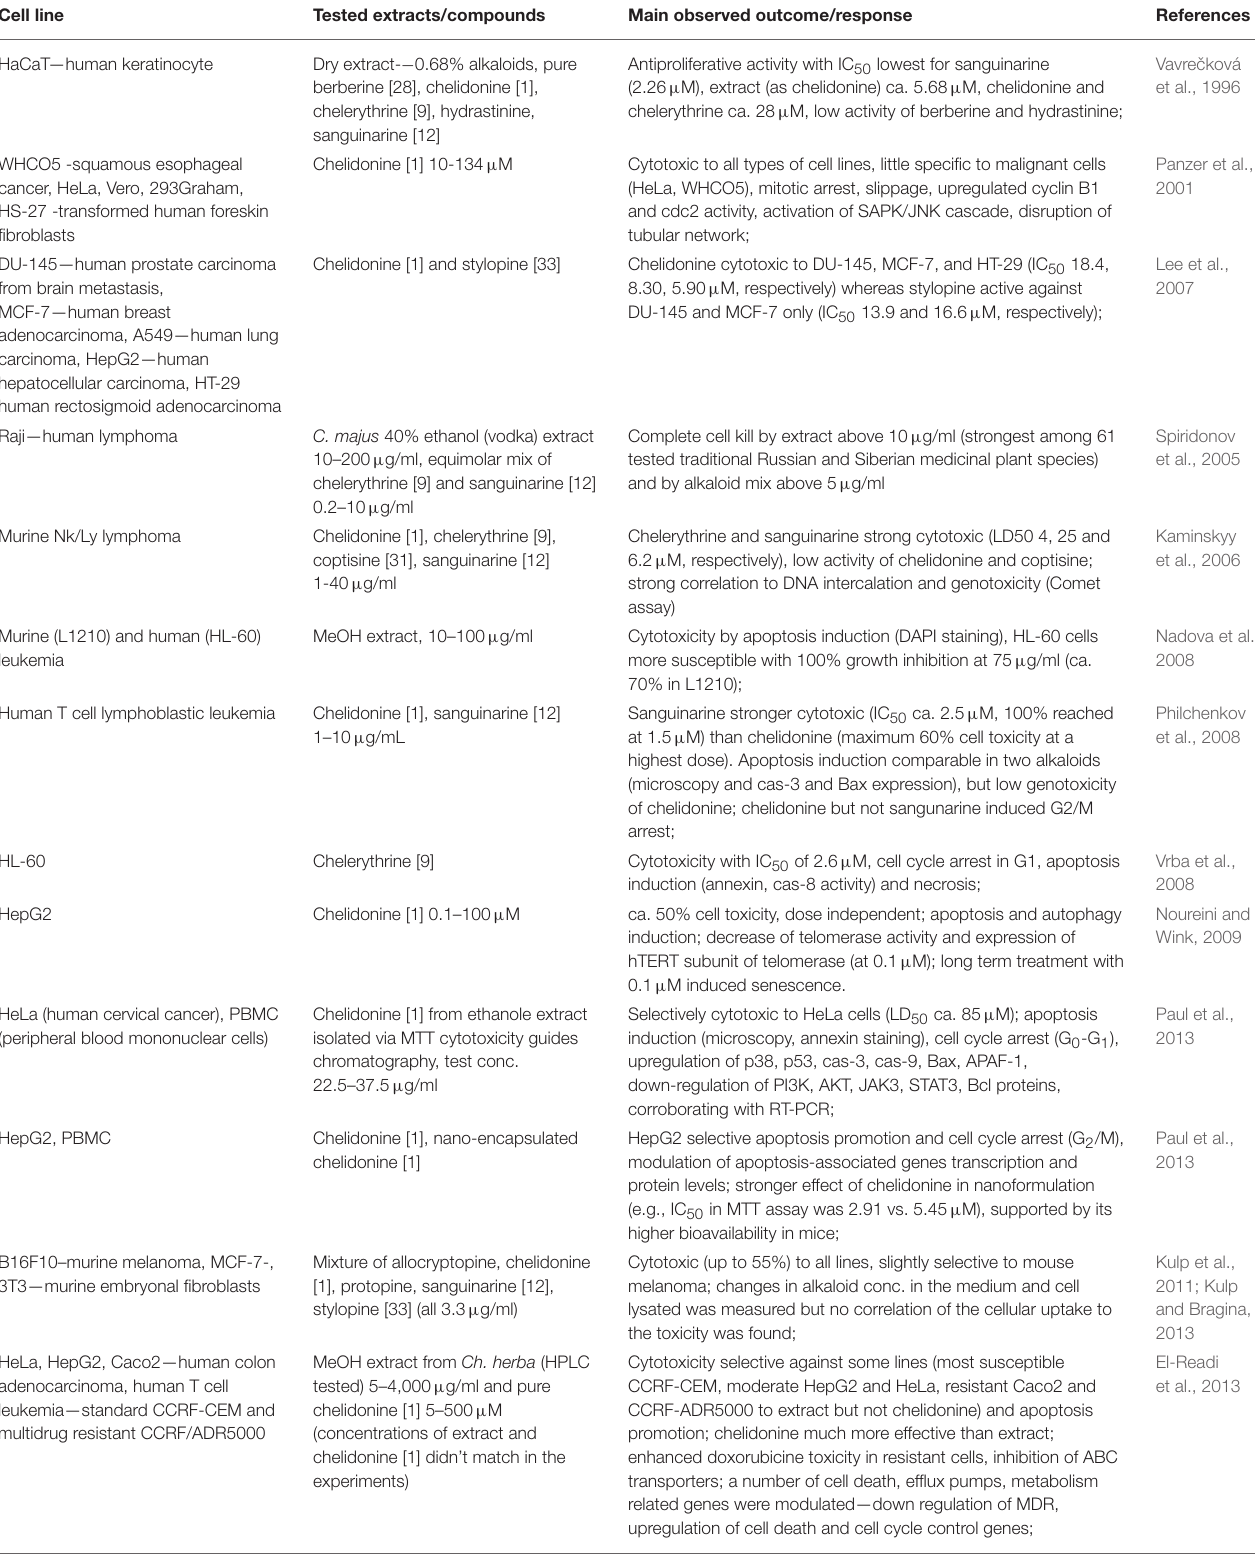
TABLE 2 | Influence of C. majus and its alkaloids on various cell lines in vitro